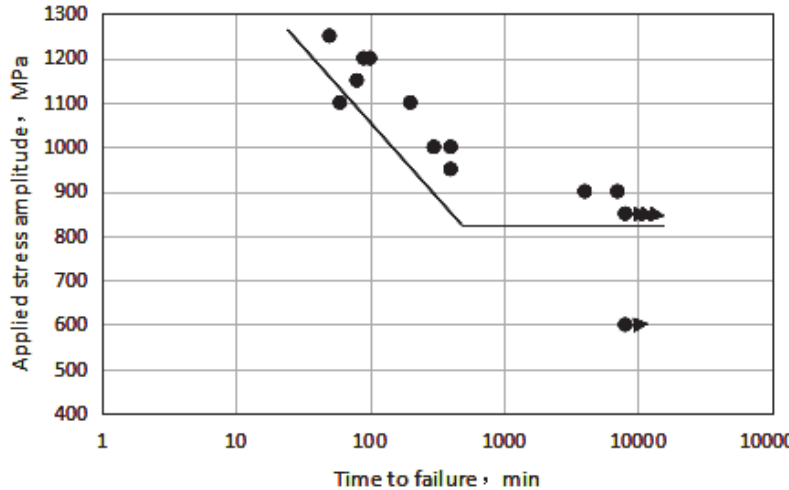
Figure 2: Curves for stress – time of failure of the experimental materials in quenching state in notched tensile experiment. Results of notched tensile experiment carried out on the experimental materials are shown in Tab. 2. Fig. 4 and 5